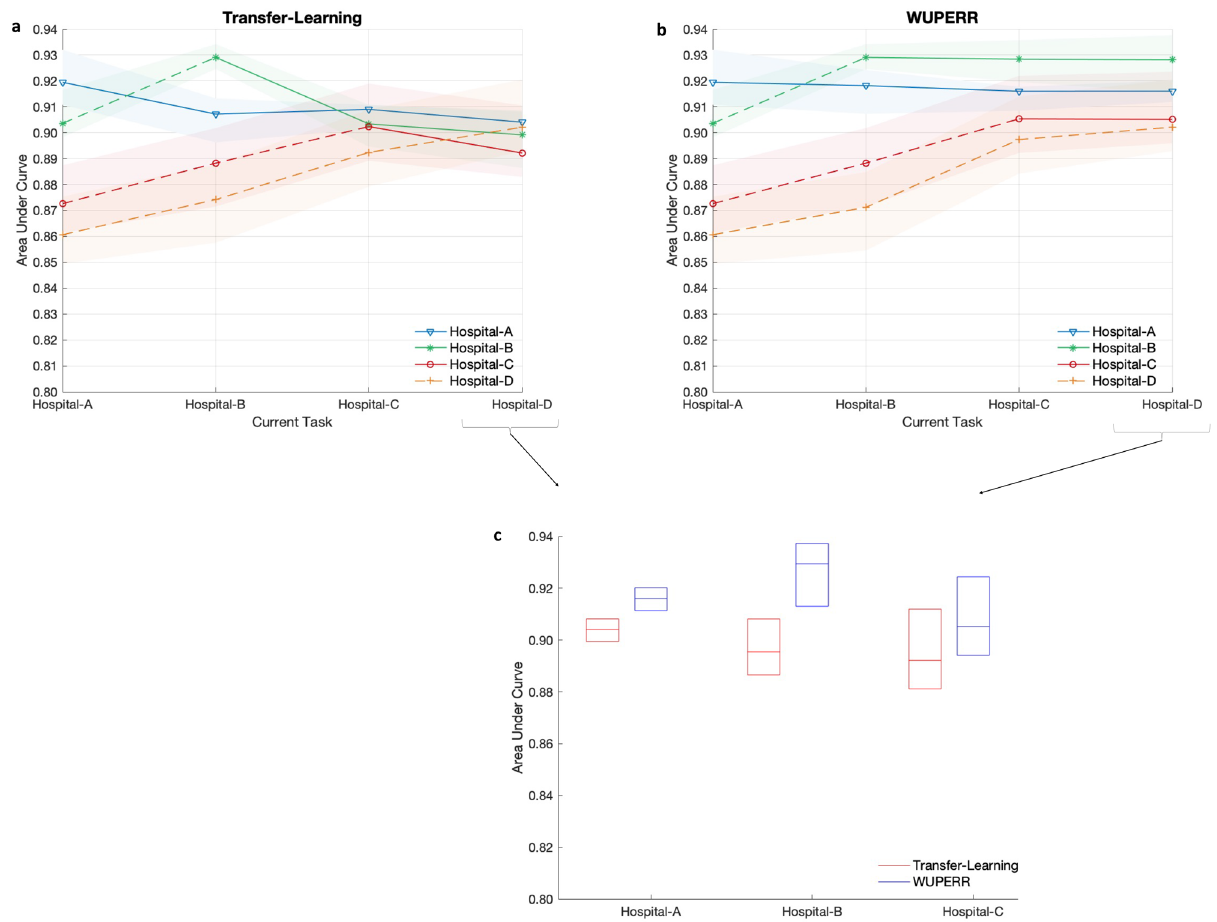
Figure 2. Evaluation of continual learning models for early predicting of onset of Sepsis, measured using Area Under the Curve (AUC) metric. ( a ) Illustrates AUC of a model (median[IQR]) trained using transfer learning. The model performance is reported (using different markers; see legend) across all the cohorts after sequential training on data from a given hospital on the x-axis. ( b ) shows the AUC of the proposed WUPERR model, under the same experimental set-up as ( a ). At the time of evaluation (on testing data) at a given site, the model is evaluated on all the hospital cohorts. The solid line-style indicates that at the time of model evaluation (on testing data) at a given site, the model had already seen the training data from that site. For instance, since the model is first trained on Hospital-A data, the performance of the model on this dataset after continual learning on all subsequent hospitals is shown in solid line-style to signify that the model had already seen this patient cohort in the past. ( c ) summarizes the model performance (median[IQR]) on Hospitals A–C after continual learning on all four hospitals with Transfer learning (red) and WUPERR